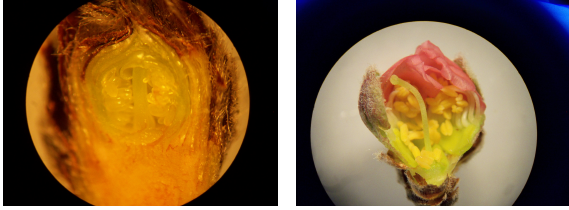
Figure 1. Peach flower buds at different stages of winter rest. The flower bud has a lower resistance to frost in (b).